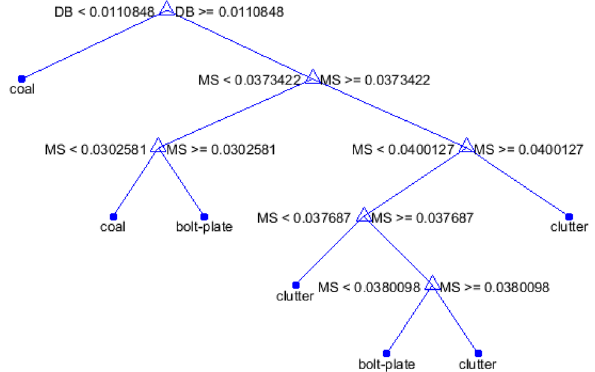
Fig. 20 Initial decision tree for classifying bolt-plates, coal and